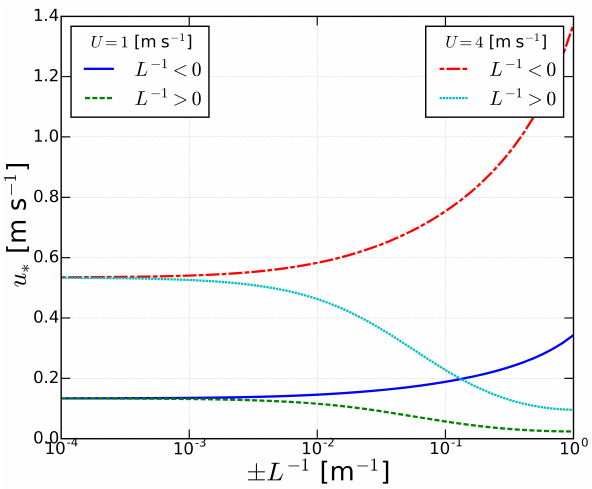
Figure A1. Friction velocity ( u ∗ ) as a function of inverse Obukhov length ( L − 1 ) for two different wind speeds ( U ) using a rough- ness length ( z 0 ) of 0.5m and wind-speed measurement height ( z ) of 10m.